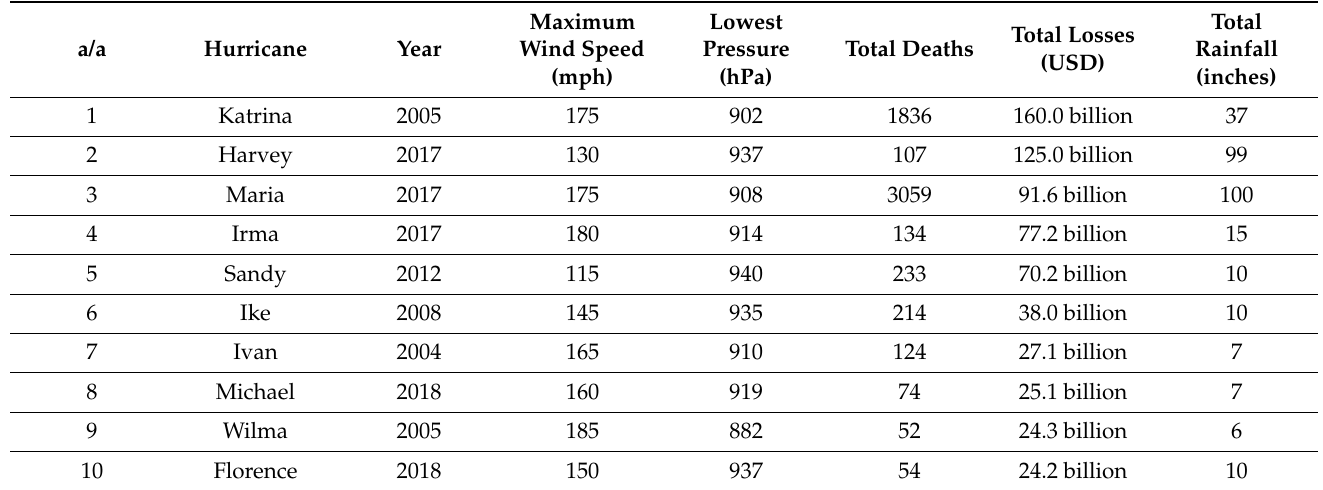
Table 3. Costliest hurricanes in the USA since